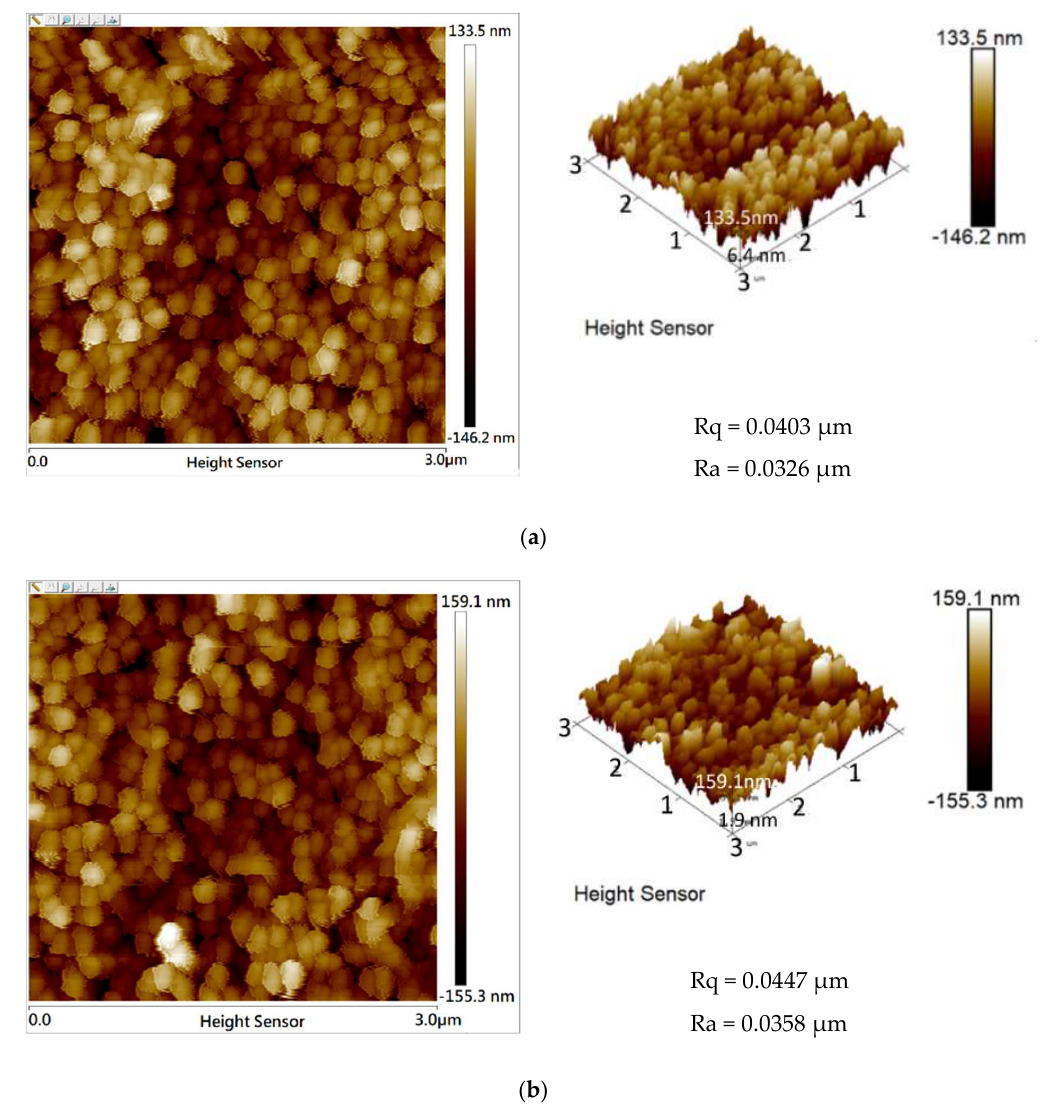
Figure 4. Atomic force microscopy (AFM) images of ZnO/ZnS core–shell/CNT structures with sulfurization times of ( a ) 15 min, the horizontal scale bar is presented from 0.0 μm to 3.0 μm and the perpendicular scale bar is presented from 133.5 nm to −146.2 nm and ( b ) 30 min, the horizontal scale bar is presented from 0.0 μm to 3.0 μm and the perpendicular scale bar is presented from 159.1 nm to −155.3 nm.